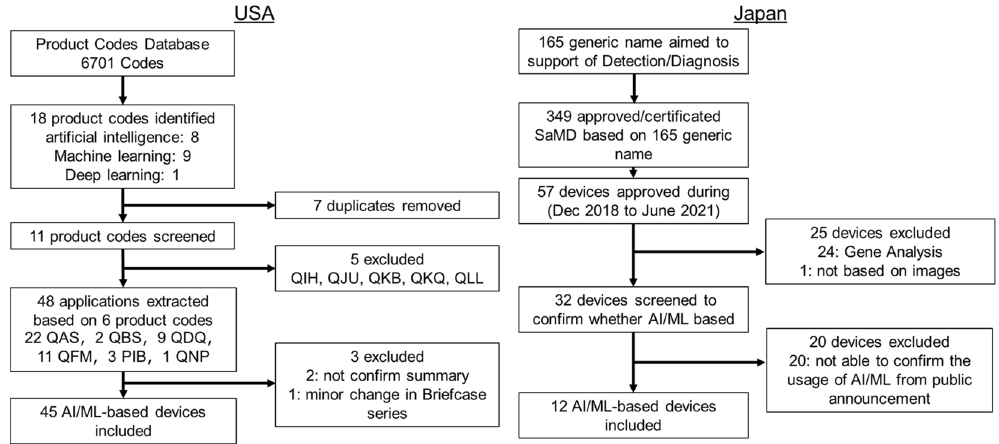
Figure 1. Flowchart for extraction of AI/ML-based CAD devices approved in the USA and